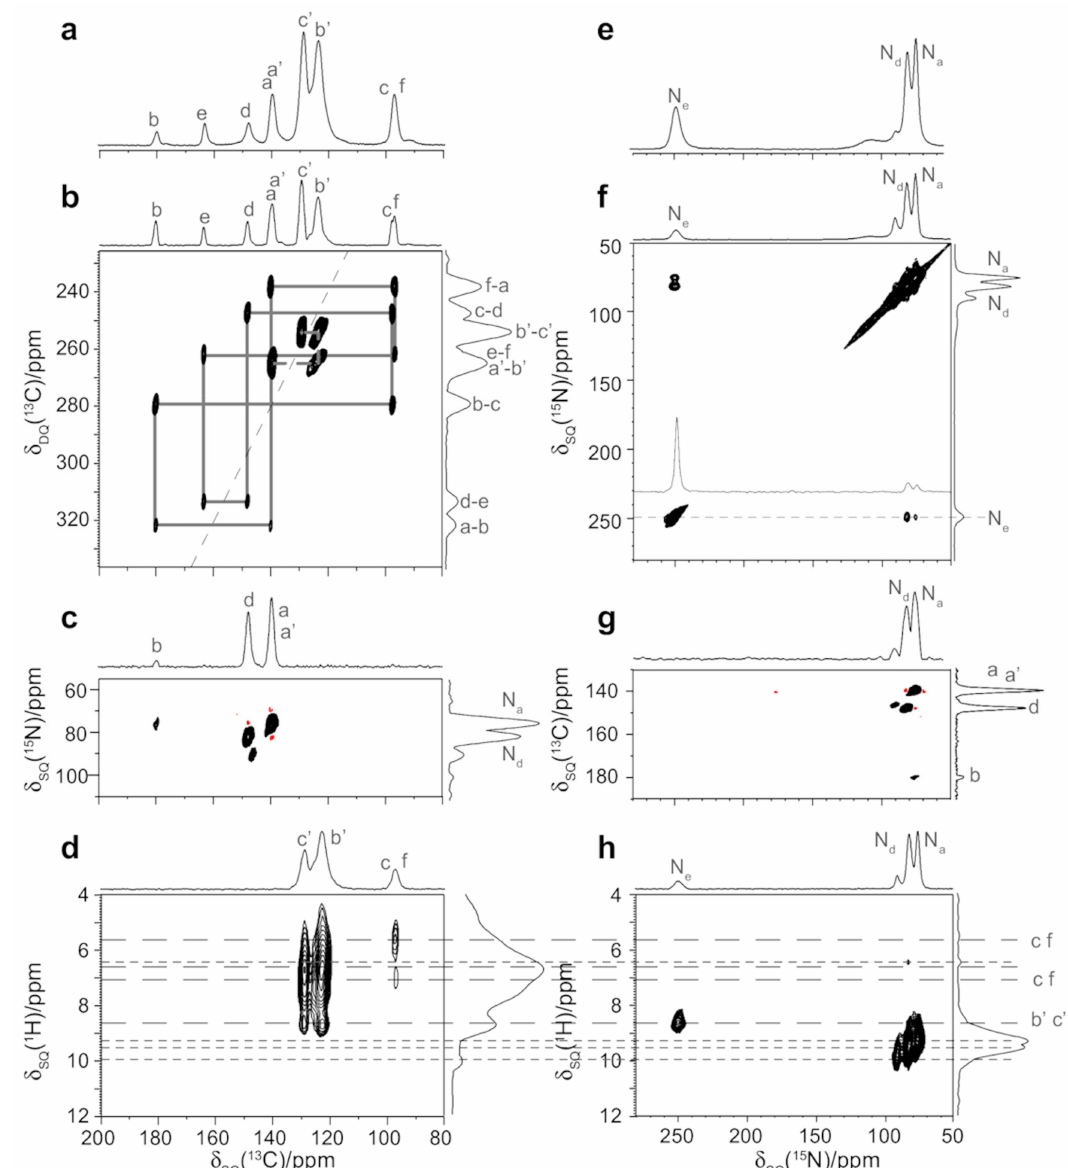
Figure 5. Solid-state MAS NMR ( 1 H Larmor frequency of 500.1 MHz) spectra of a PANI sample synthesized using alanine and ammonium persulfate by the “falling pH” reaction: One-dimensional ( a ) 13 C CP / MAS (20 kHz) and ( e ) 15 N CP / MAS (12.5 kHz) spectra. ( b ) A 13 C- 13 C refocused INADEQUATE (20 kHz MAS, 1.0 ms spin-echo duration) spectrum. ( c , g ) A double CP heteronuclear 13 C- 15 N (12.5 kHz MAS) spectrum recorded with 1 H- 15 N and 15 N- 13 C contact times of 1.0 and 5.0 ms, respectively. In ( g ), the spectrum has been rotated through 90 degrees away from the usual convention, such that the horizontal dimension corresponds to the indirect 15 N dimension, so as to allow comparison with the other spectra presented in the right-hand column of the Figure ( d , h ) Heteronuclear ( d ) 13 C- 1 H (10 kHz MAS) and ( h ) 15 N- 1 H (12.5 kHz) refocused INEPT spectra employing eDUMBO22 1 H homonuclear decoupling with spin-echo durations of (d) 0.6 and (h) 3.2 ms. ( f ) A two-dimensional 15 N- 15 N proton-driven spin di ff usion spectrum with a mixing time of 2.0 s. The spectra ( a – d , g ) were recorded on a sample synthesized starting from a 50:50 mixture of U- 13 C aniline and 15 N-labelled aniline, while the spectra ( e , f , h ) were for a sample synthesized using 15 N-labelled aniline. Reprinted with permission from reference [12]. Copyright (2015) American Chemical